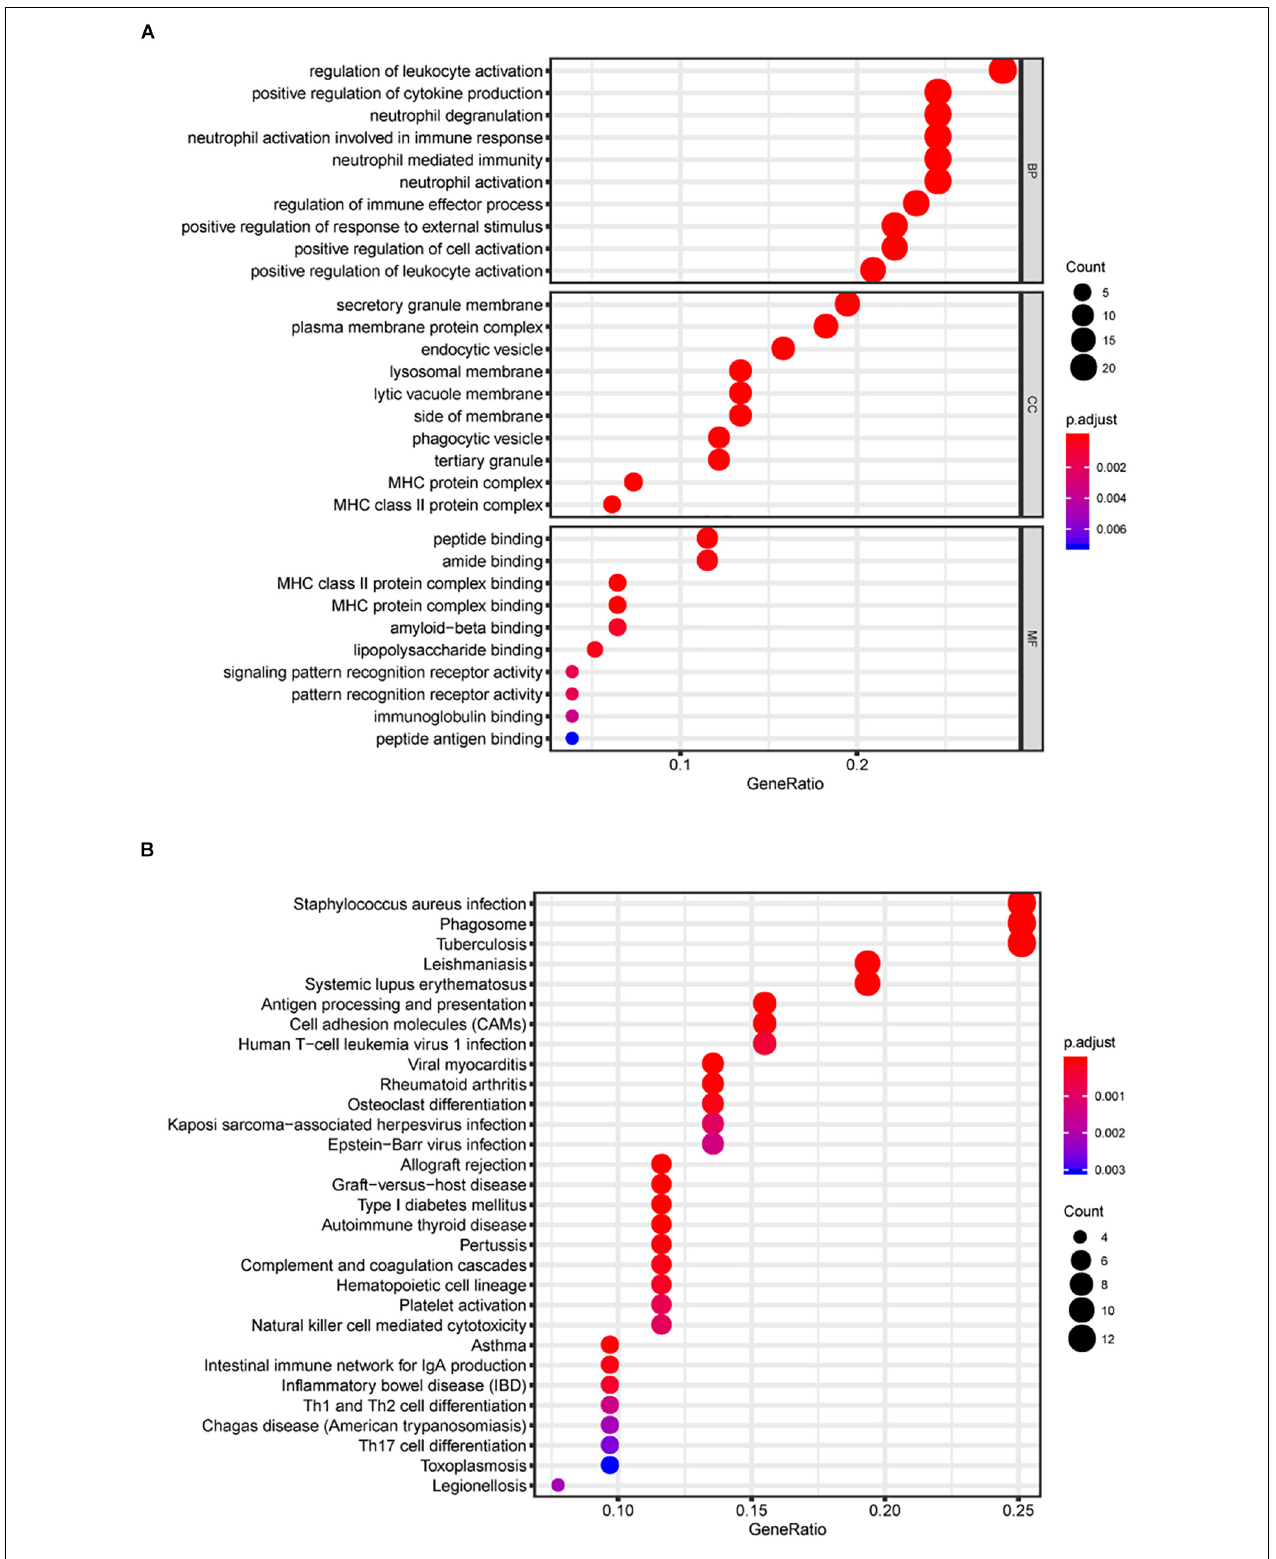
FIGURE 3 | Gene Ontology (GO) and KEGG pathway analyses. In total, 30 GO biological process consisting of 10 biological processes (BP) terms, 10 cellular components (CC) terms, and 10 molecular functions (MF) terms were enriched (A) . Kyoto Encyclopedia of Genes and Genomes (KEGG) pathway analysis (B) .